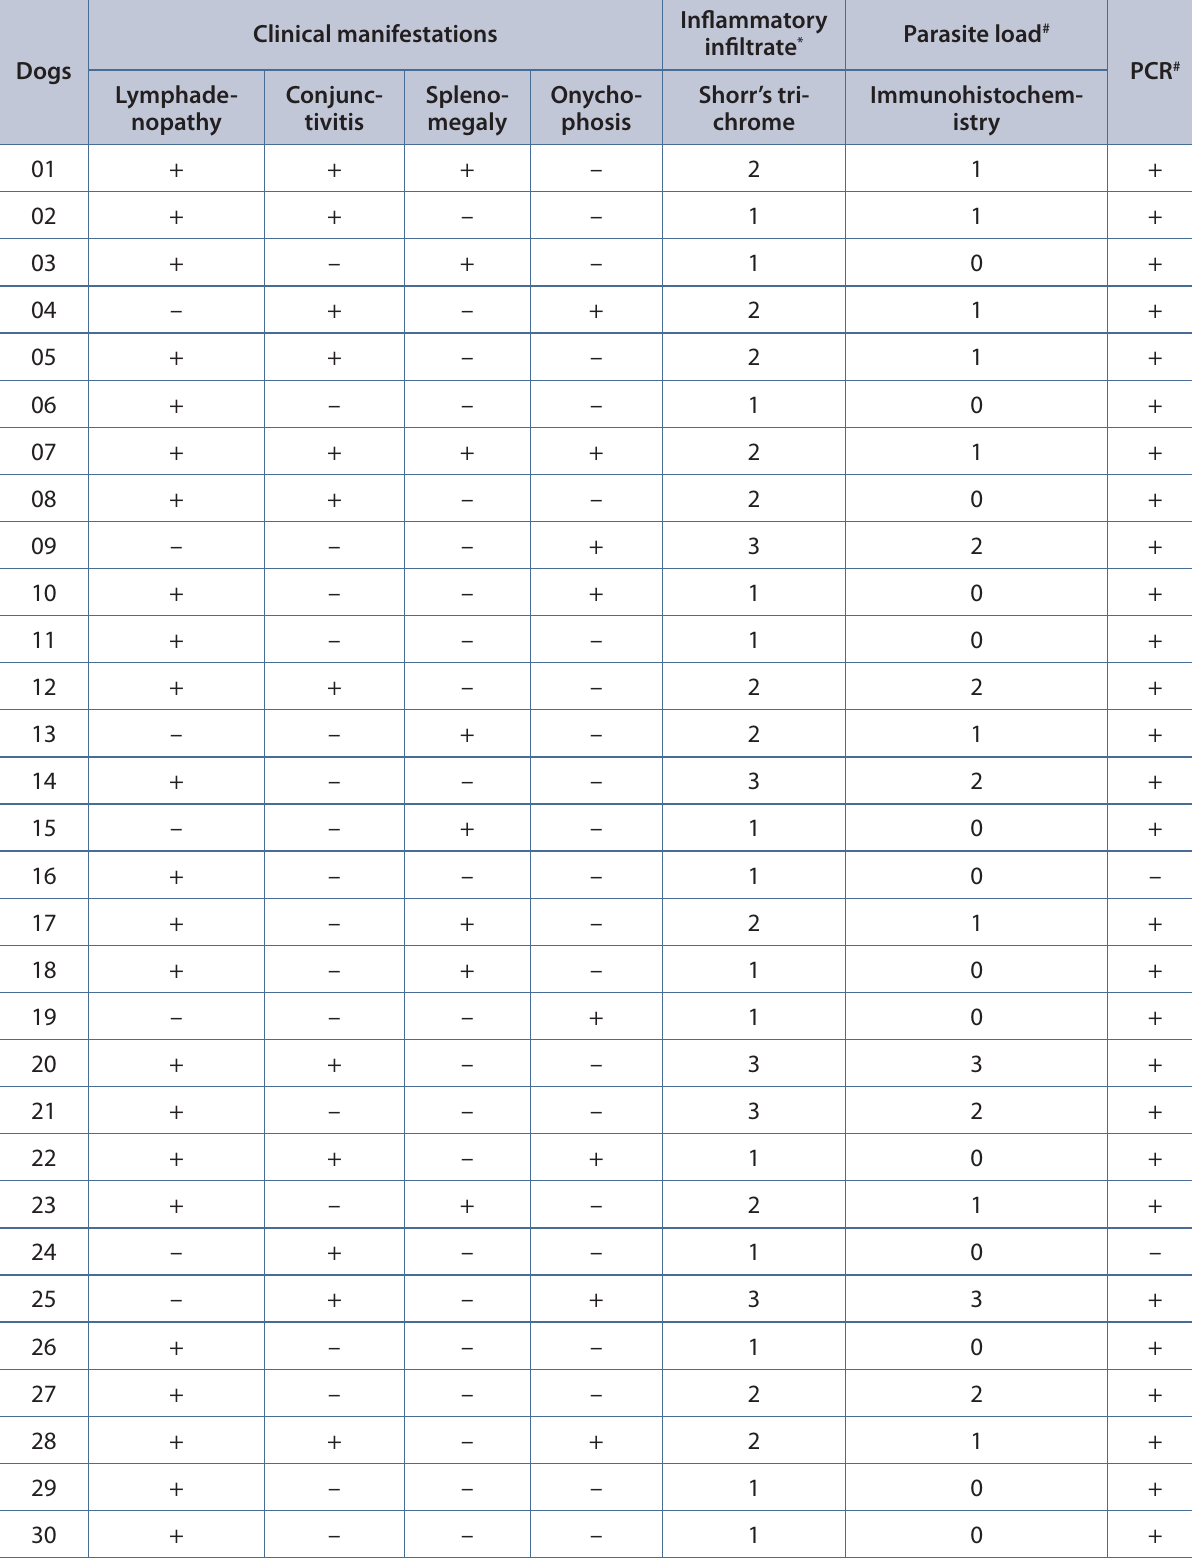
Table 1. A ssociation among inflammatory infiltrate, parasite load and clinical signs in canine leishmaniasis (n = 30)